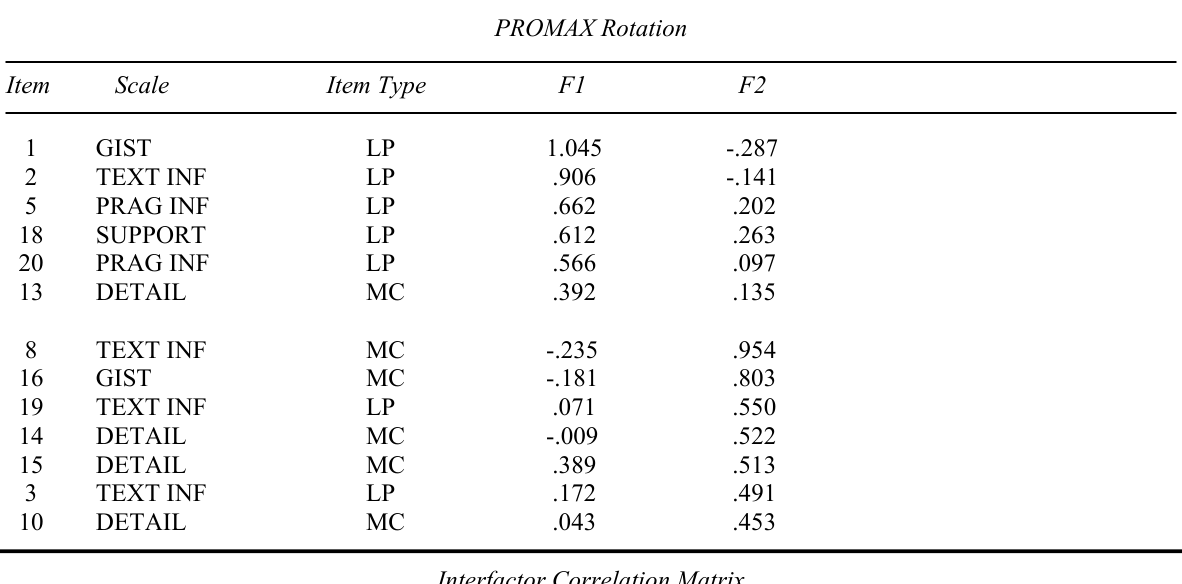
Pattern Matrix and Interfactor Correlations for the 13-Item